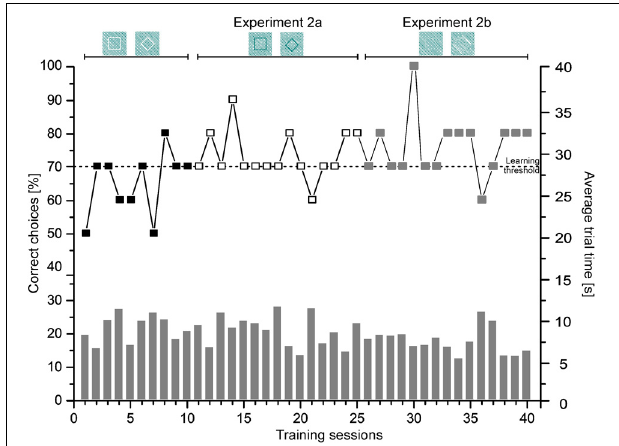
FIGURE 7 | Experiment 2. Shown is the performance of Shark 8 as % of correct choices per session (symbolized by boxes; left ordinate) as well as the average trial time (s) per session (symbolized by gray bars; right ordinate) per phase until the learning criterion was reached.